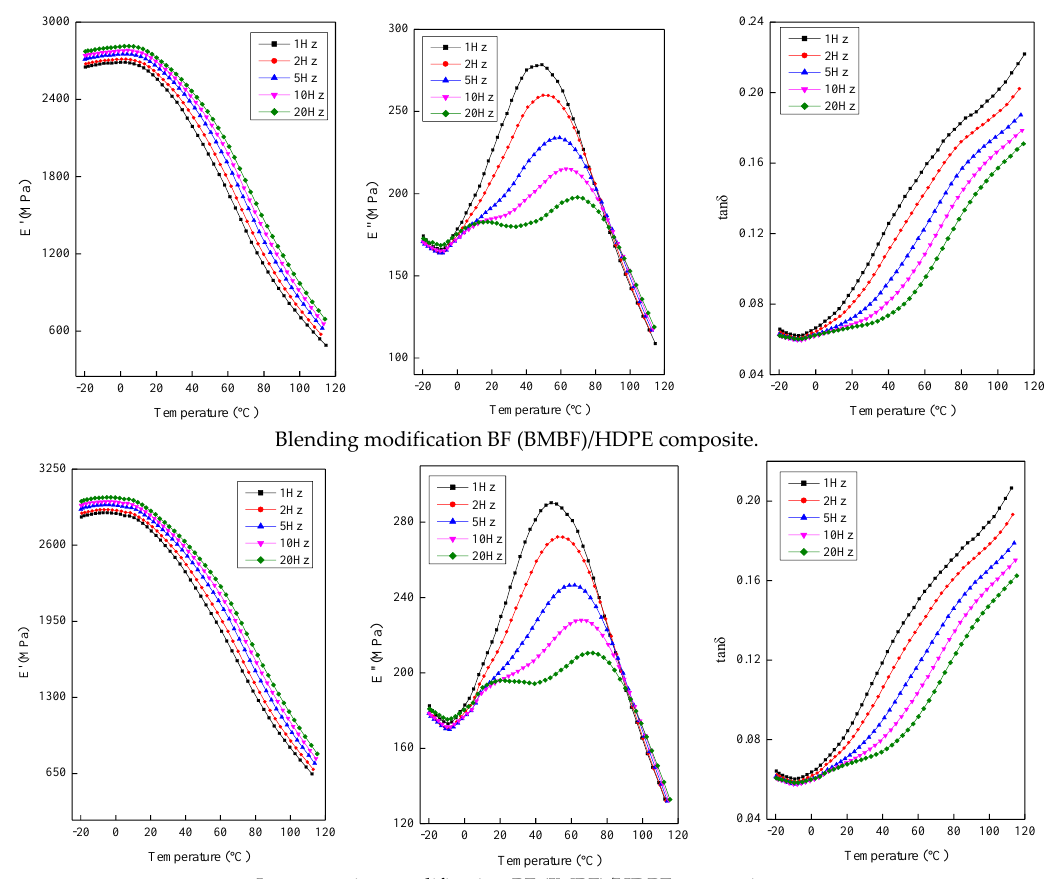
Figure 4. Multiple-frequency dynamic thermo-mechanic properties of composites.